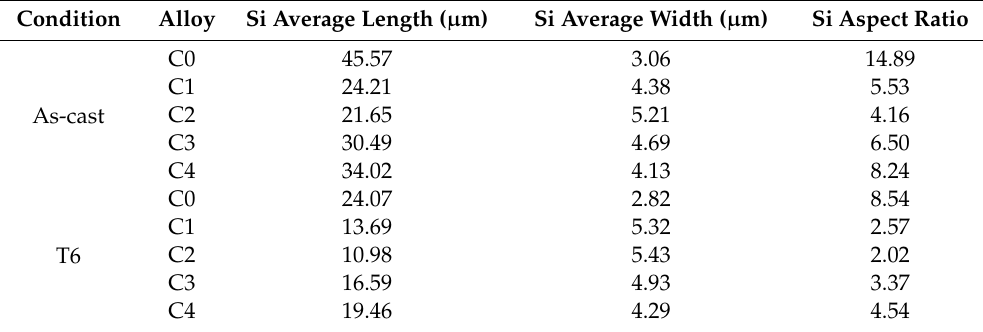
Table 2. Eutectic silicon parameters of different Ce content A357 alloy.